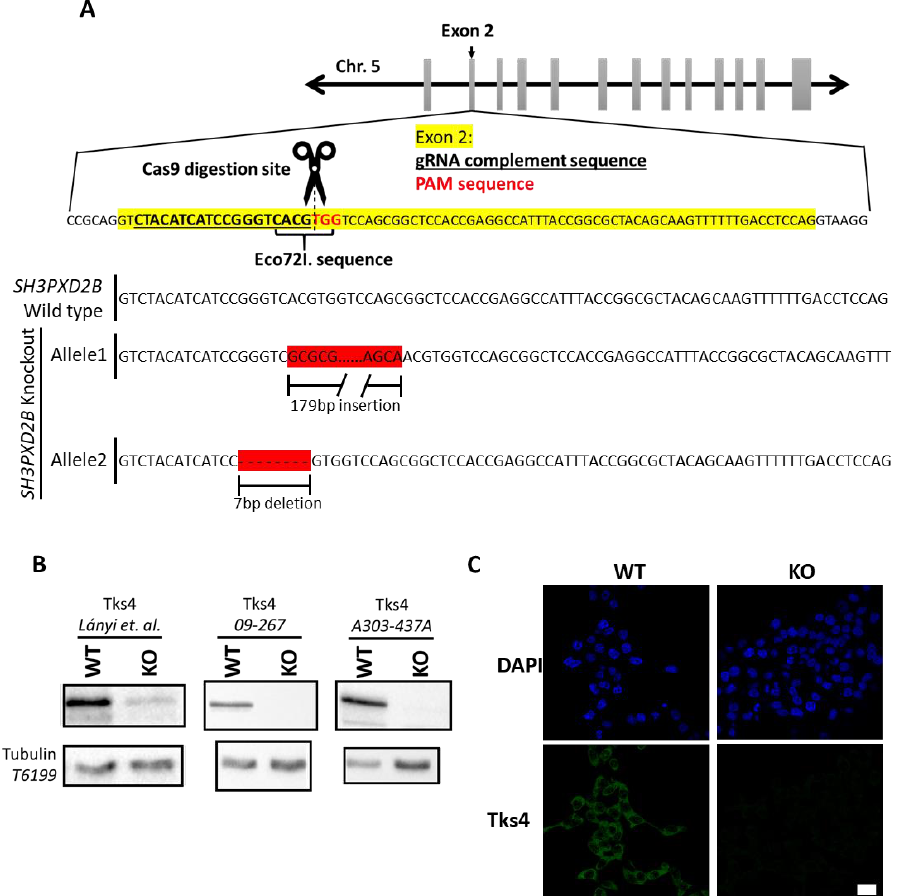
Figure 1. Deletion of SH3PXD2B via CRISPR/Cas9 in HCT116 cells. ( A ) Human SH3PXD2B is located on chromosome 5. Exon 2 is highlighted with a yellow background, the gRNA complement sequence is underlined, and the PAM sequence is indicated with red nucleotides. SH3PXD2B knockout “Allele1” contains a 17-bp long insertion, and “Allele2” contains a 7-bp deletion. ( B ) Validation of the absence of Tks4 protein via Western blotting, with multiple antibodies. ( C ) Representative fluorescent images of wild type and Tks4-KO cell cultures. Nuclei were visualized with DAPI (blue), while Tks4 is shown in green. Scale bar represents 10 µm.